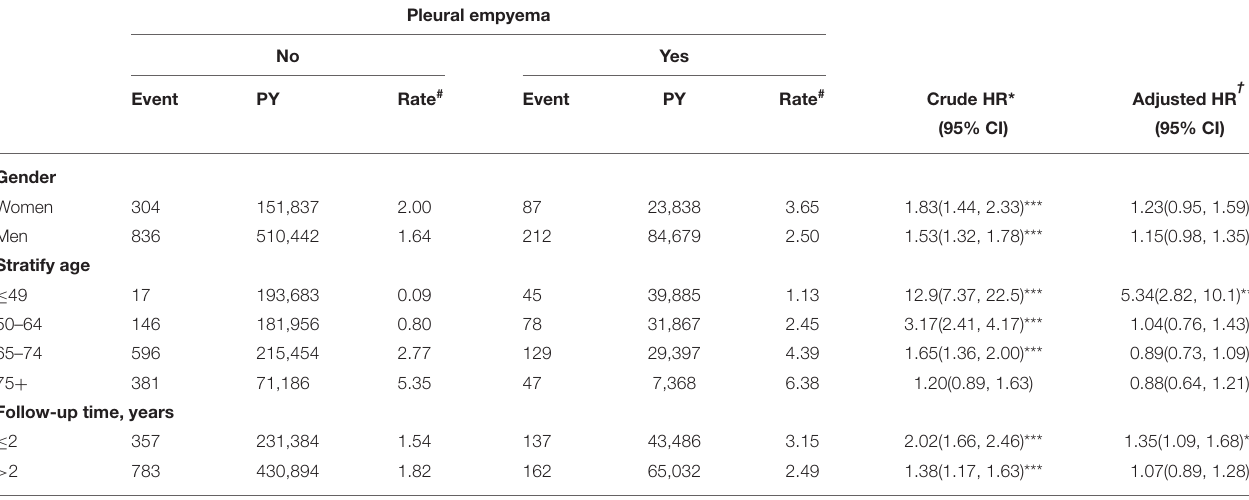
TABLE 3 | Comparison of incidence densities of peripheral arterial disease hazard ratio between with and without pleural empyema by gender, age, and follow-up time. Pleural